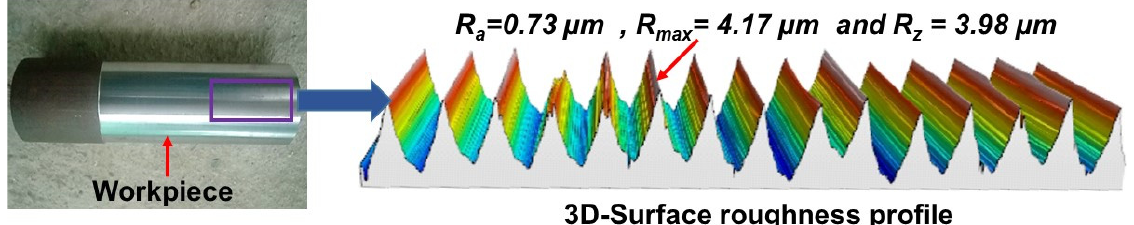
Figure 6. 3-D profile of best finished surface of AISI 4340 alloy steel workpieces obtained at V = 146 m/min, d = 0.4 mm, f = 0.1 mm/rev.